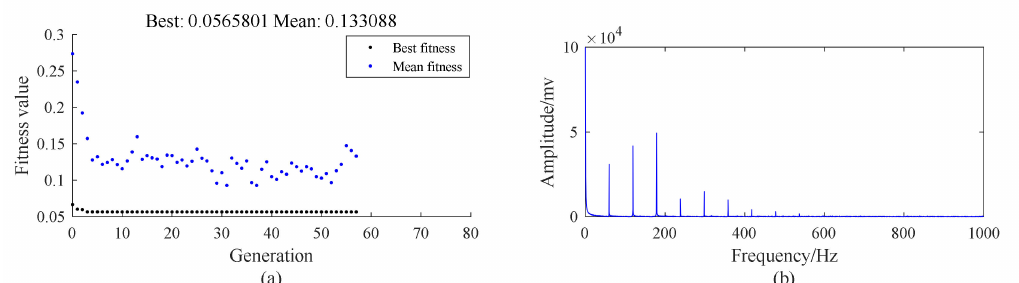
Figure 25. The diagnosis result of the collected signal for the bearing with 1 mm outer race fault processed by the Optimal Wavelet Packet Transform (OWPT): ( a ) the training performance of the OWPT; ( b ) the squared envelope spectrum